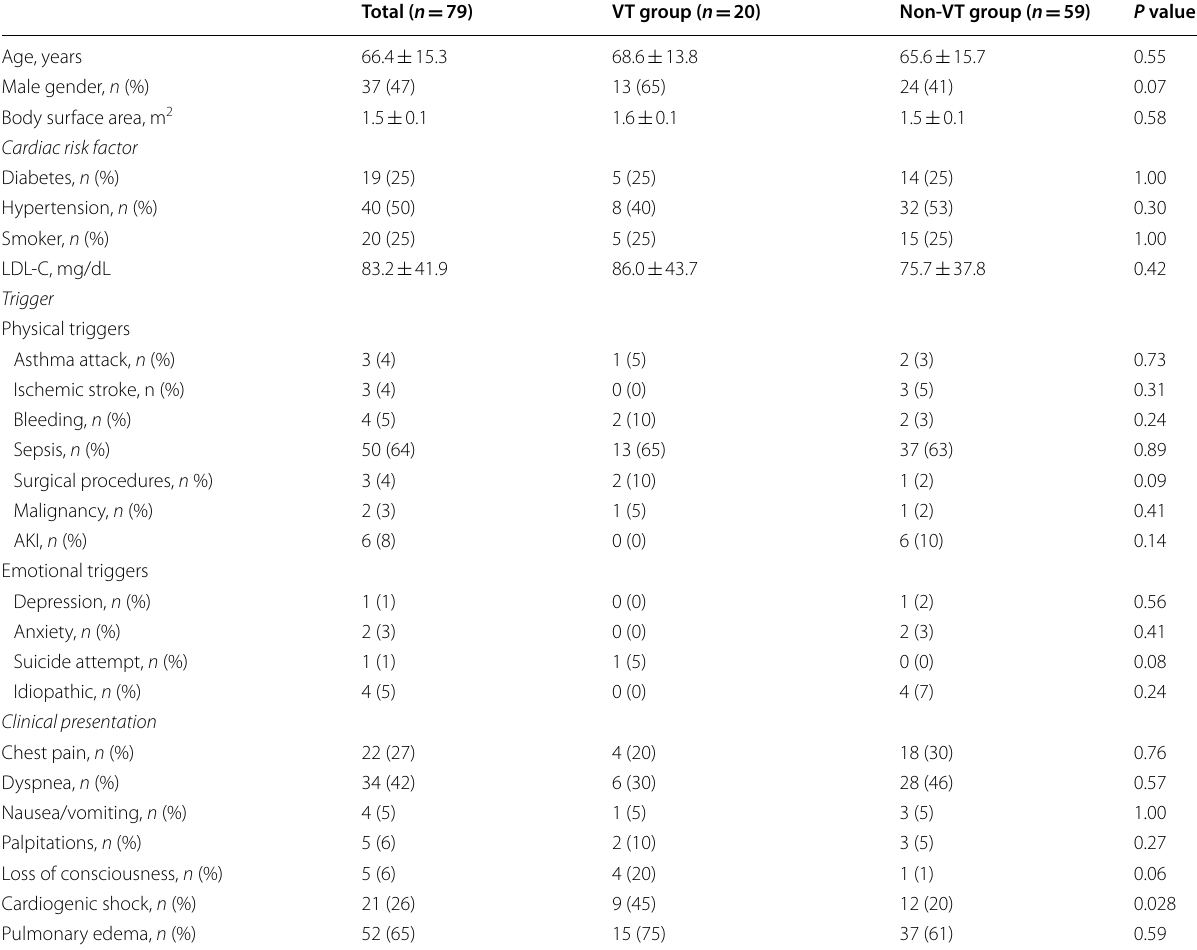
Values are mean SD or number (%); VT ventricular tachycardia; CRF chronic renal failure; LDL-C low-density lipoprotein cholesterol; others idiopathic; P value by ± Student t -Test and Mann–Whitney U